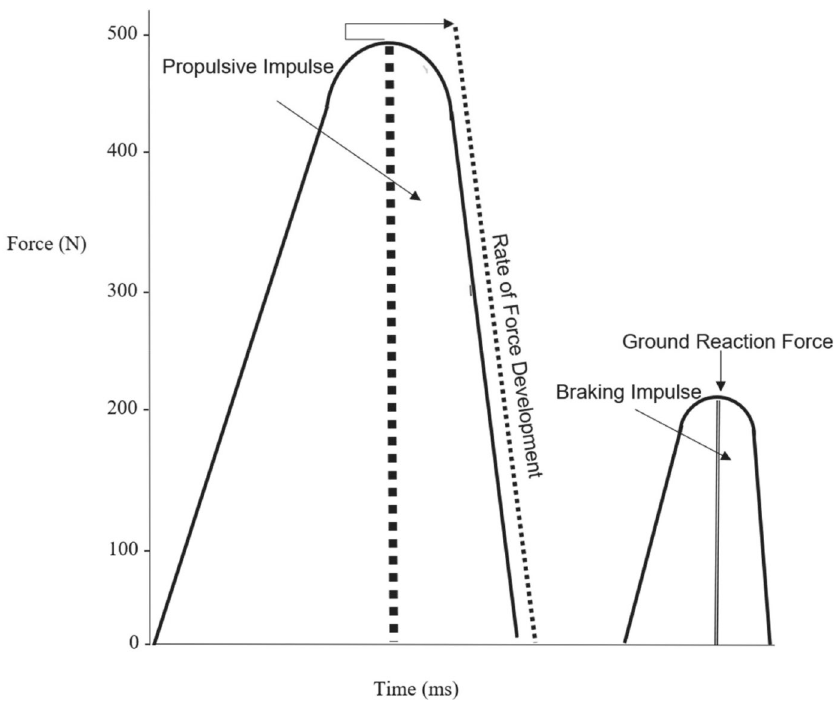
Table 1 - Force-plate measurements following a drop jump.